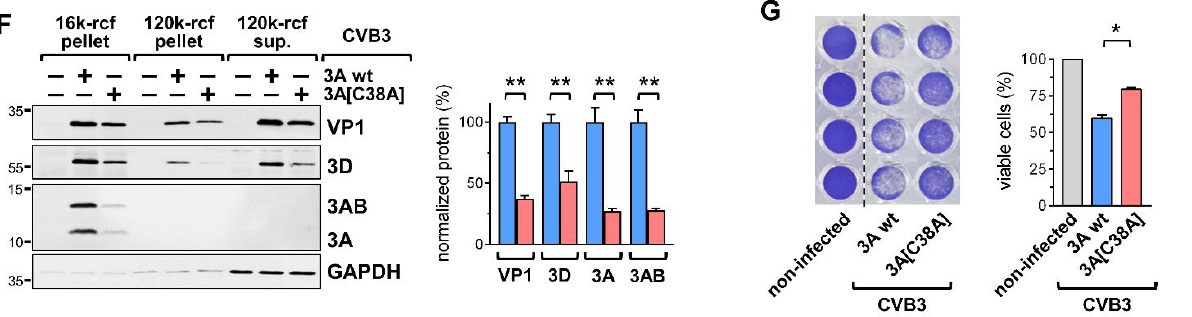
Figure 3. Cysteine 38 of protein 3A supports virus replication. ( A ) HeLa cells were infected with GFP-CVB3 encoding wt protein 3A, 3A[C38A], or 3A[C38S] at MOI 1 for 5 h. Virus titers were determined by plaque assay. ( B ) HeLa cells were infected with GFP-CVB3 variants at MOI 1 for 5 h. Fluorescence microscopy with the 488 nm excitation of infected cells. ( C ) Analysis by flow cytometry to assess t h e percentage of GFP positive cells and mean fluorescence intensity (MFI) of GFP in GFP-positive cells. ( D ) Disulfide-linked enteroviral protein 3A promotes viral replication. HeLa cells were infected with GFP-CVB3 encoding protein 3A wt or 3A[C38A] at MOI 0.01 for the indicated periods. Fluo- rescence microscopy at 30× magnification with 488 nm excitation of infected cells. ( E ) The amount of infectious virus was